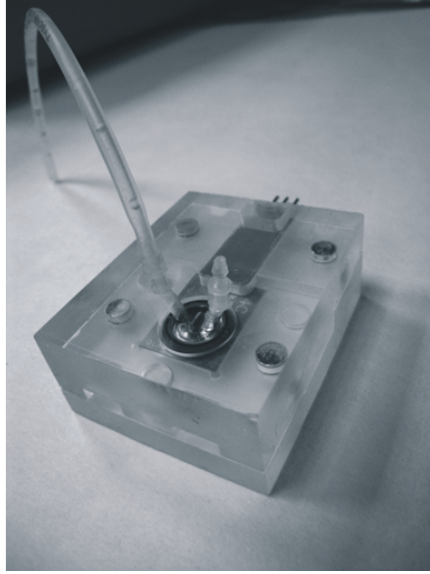
Figure 2. Biosensor mounted into the measurement cell. The inlet and outlet tubes can be